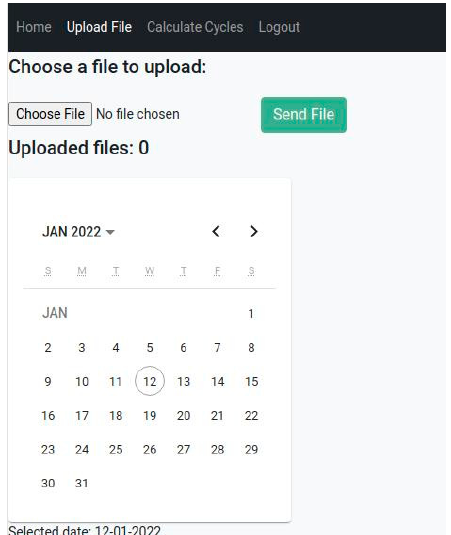
Figure 4. Complete system workflow.